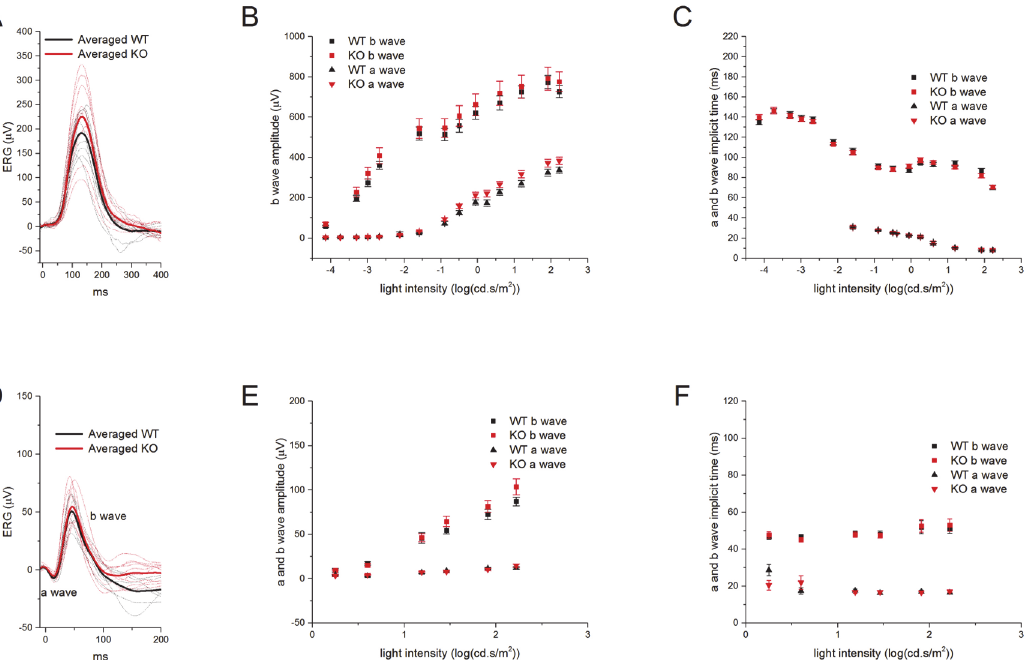
Fig 4. Comparison of the ERGs of TRPM3 -/- and TRPM3 +/+ mice. A ) Traces of low pass-filtered scotopic ERGs from TRPM3 +/+ (black) and TRPM3 -/- (red) mice. The flash intensity was-3.3 log(cd-s/m 2 ). Each dashed line is the averaged response from one eye. The thick lines are averages for each genotype. The amplitude ( B ) and implicit time ( C ) of the scotopic a- ( ▲ ) and b- ( ■ ) waves at different light intensities are plotted for TRPM3 +/+ (black) and TRPM3 -/- (red) mice. Data points show the mean with the standard error of the mean. D ) Traces of low pass-filtered photopic ERGs from TRPM3 +/+ (black) and TRPM3 -/- (red) mice. The flash intensity was 1.91 log (cd-s/m 2 ) under 100 cd/m 2 white light background. Each dashed line is the averaged response from one eye. The thick lines are averages for each genotype. The amplitude ( E ) and implicit time ( F ) of the photopic a- ( ▲ ) and b- ( ■ ) waves at different light intensities are plotted for TRPM3 +/+ (black) and TRPM3 -/- (red) mice. Data points show the mean with the standard error of the mean.